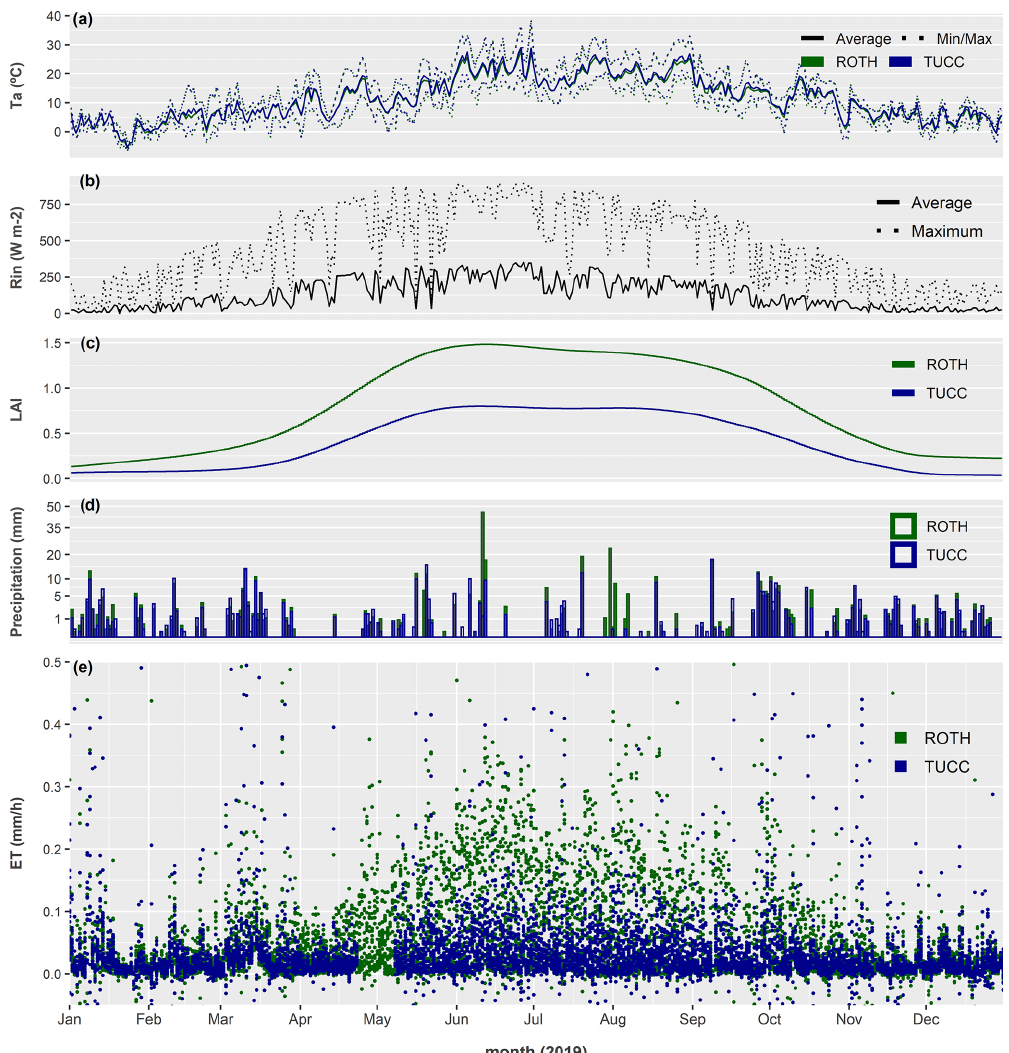
Figure 2. Time series of the main variables used in this study for both sites in 2019, where the green colour represents the data from the ROTH site and blue, the TUCC site. (a) Air temperature ( T a ), where the dotted lines represent the maximum and minimum daily values and solid lines represent average daily values; (b) incoming shortwave radiation ( R in ) is common for both sites, where the solid black line represents the average and the dotted line, the maximum daily values; (c) LAI RS-derived values; (d) the volume of precipitation (mm); and (e) the evapotranspiration observations from the EC towers